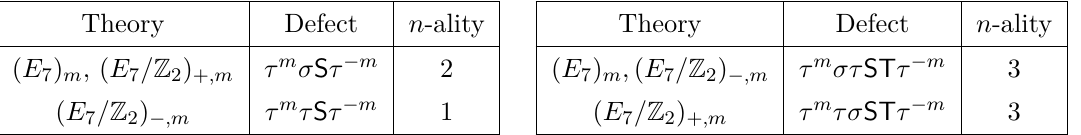
Table 10 . (Non-)invertible symmetries of e 7 at τ YM = i (left) and τ YM = e 2 πi/ 3 (right).